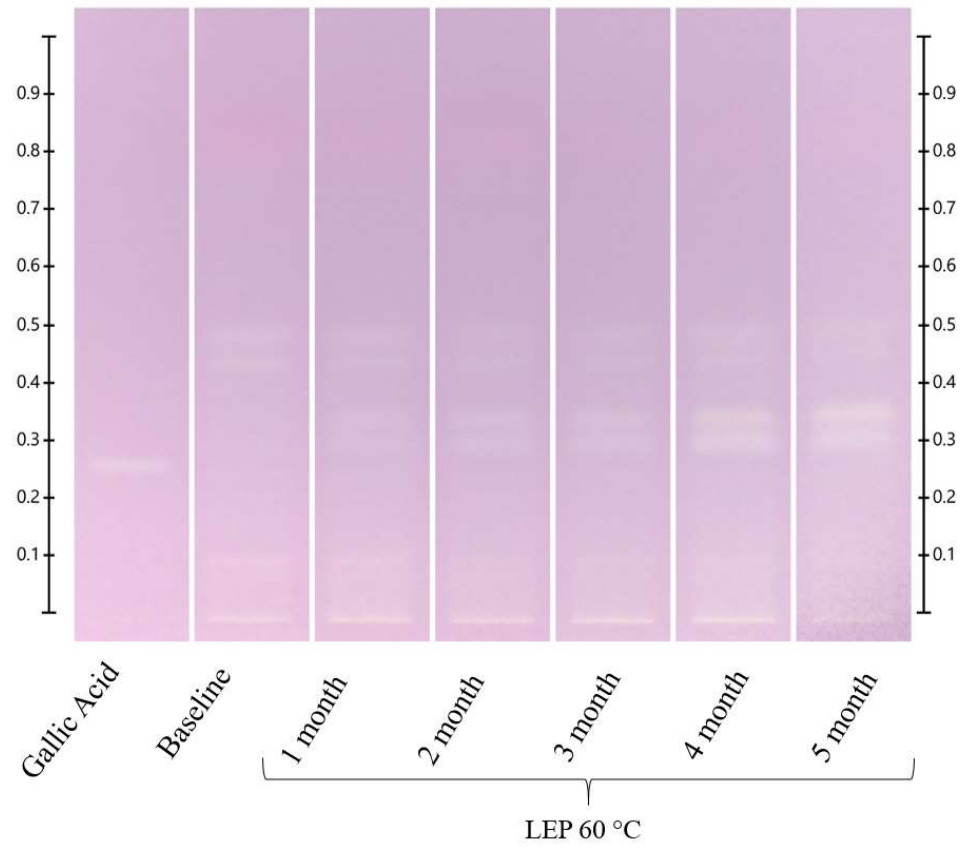
Figure 9. HPTLC-DPPH fingerprints of LEP honey stored at 60 °C for up to 5 months. Images of the HPTLC plate were taken under white light after 60 min of derivatization with DPPH* reagents, gallic acid (4 μL) and honey extracts (5 μL), respectively.